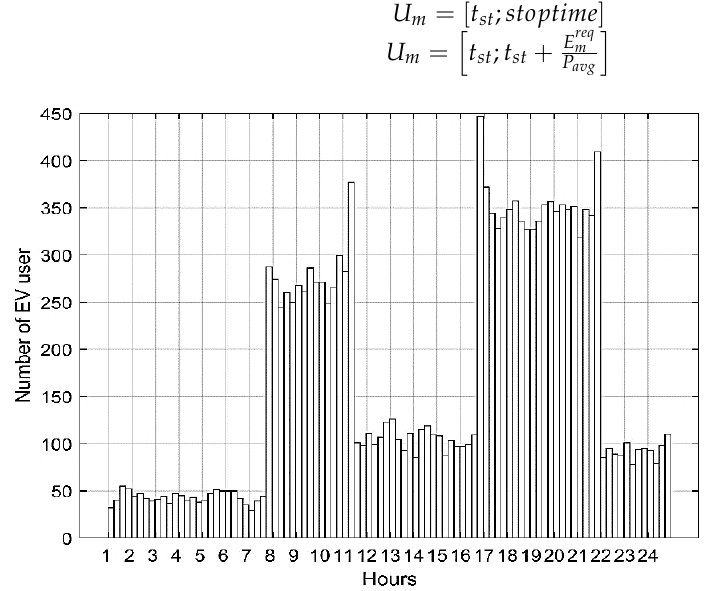
Figure 4. Charging start time histogram for 16 K EVs .